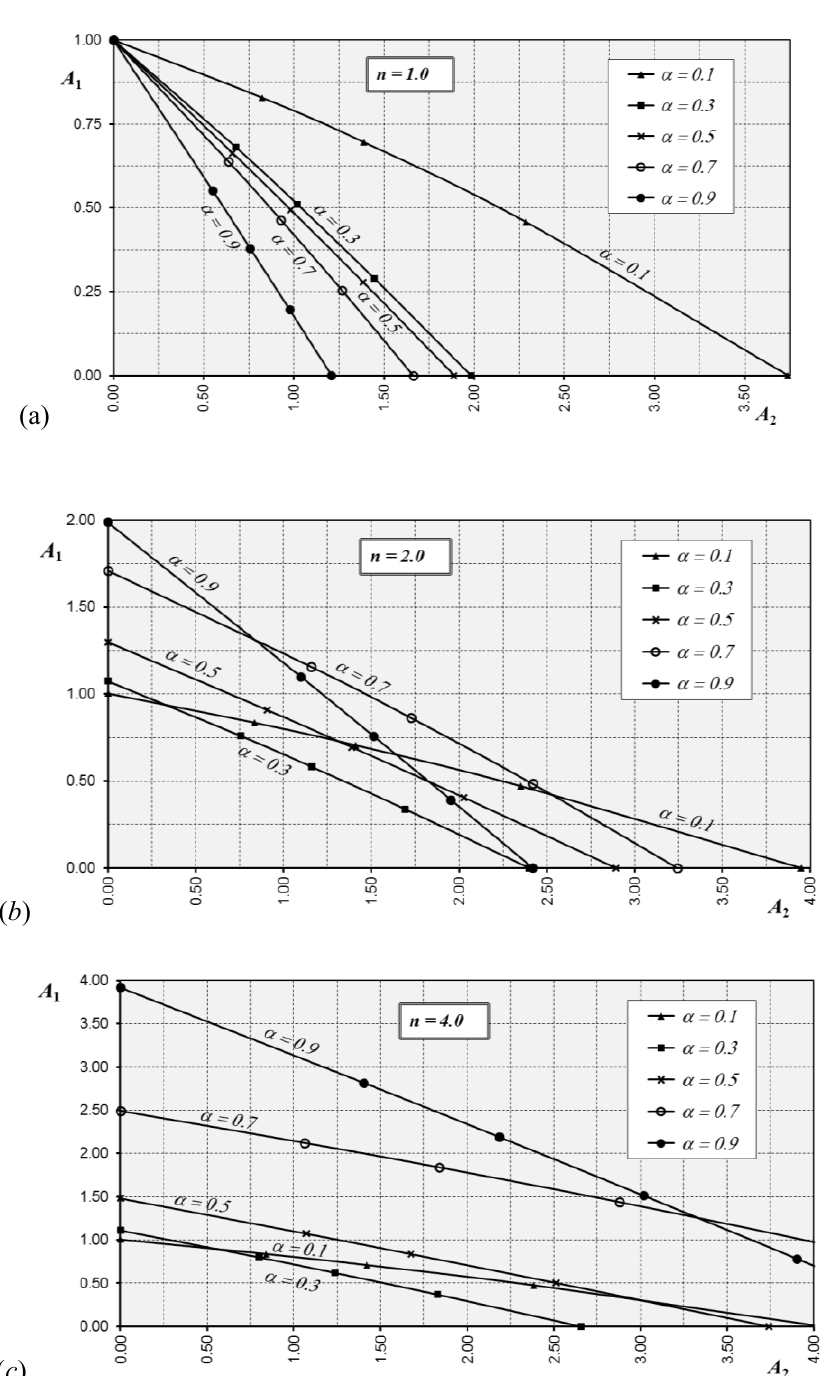
Fig. 3. Bucking loads parameters of columns with pinned ends (P-P) under intermediate load P and end load P 2 1 (a) n=1.0, (b) n=2.0 and (c)